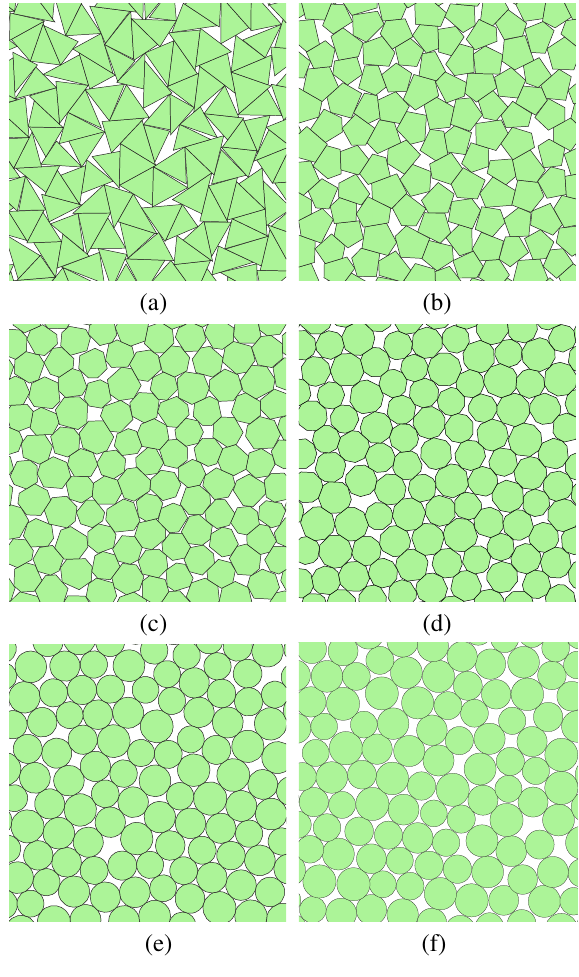
Figure 1. Particle scale views of dense samples at end isotropic compression: (a) n s = 3, (b) n s = 5, (c) n s = 7, (d) n s = 10,(e) n s = 20, and (f)